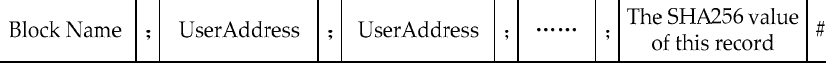
Figure 4. The logical structure of “Block Name File”.